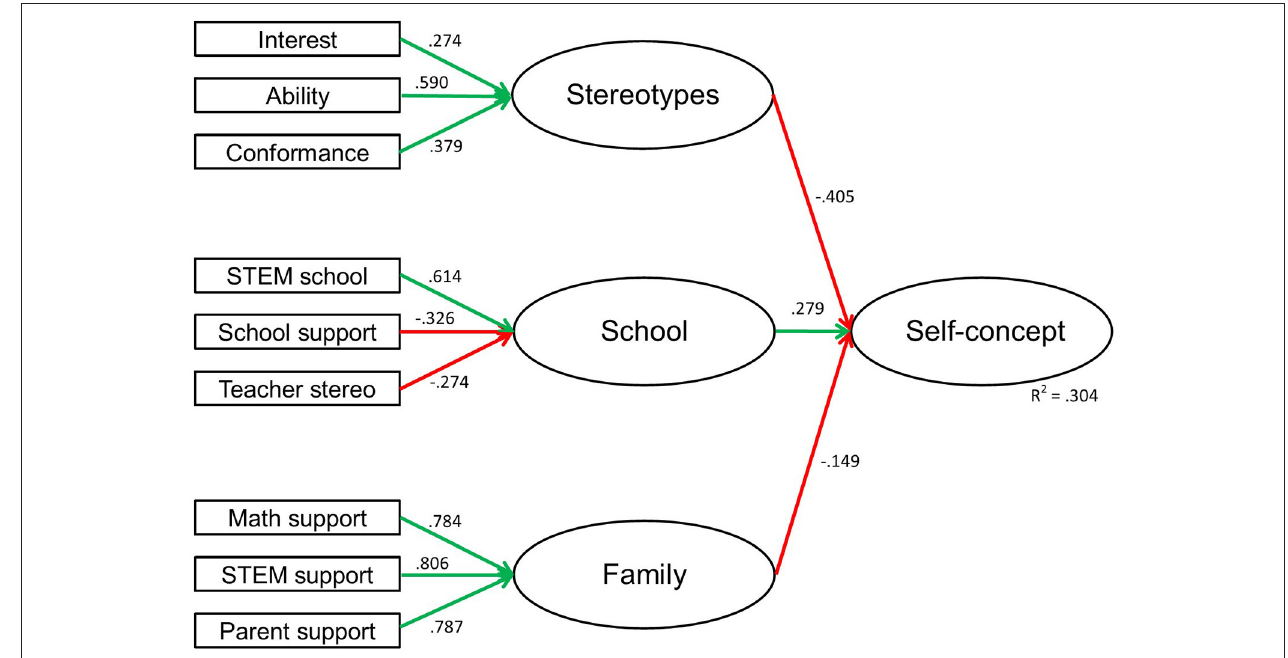
FIGURE 1 | Latent regression analysis